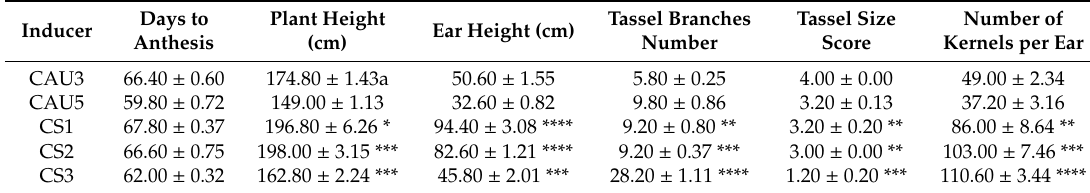
Table 2. Performance of the agronomic traits among the three candidate haploid inducer lines compared with CAU3 and CUA5.